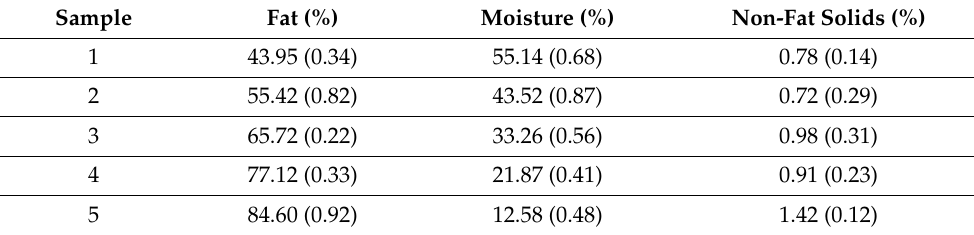
Table 1. Physicochemical parameters of butter samples express as mean